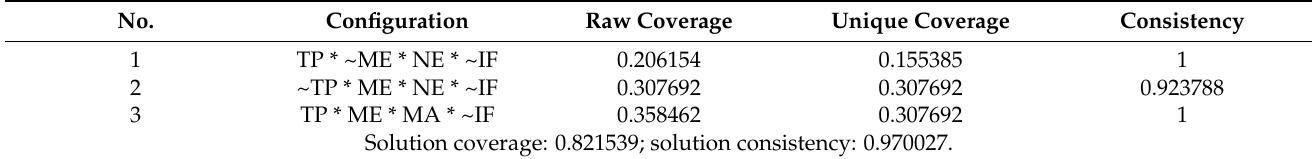
Table 4. Conditional combination path analysis results of the rebound of online public opinion in public emergencies. No.